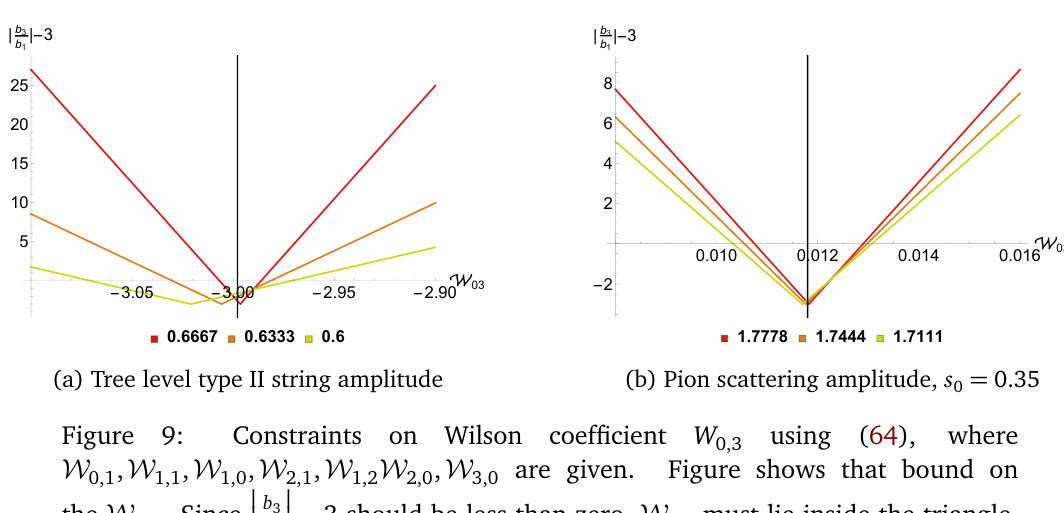
(b) Pion scattering amplitude, s Figure 9: Constraints on Wilson coefficient W using (64), where 0,3 W W , W , W , W , W , W are given. Figure shows that bound on 0,1 1,1 1,0 2,1 1,2 2,0 3,0 (cid:12) (cid:12) b 3 − 3 should be less than zero, W (cid:12) (cid:12) the W . Since must lie inside the triangle. 0,3 0,3 (cid:12) (cid:12) b 1 Black dashed line is the exact answer. Different values of a are indicated with different